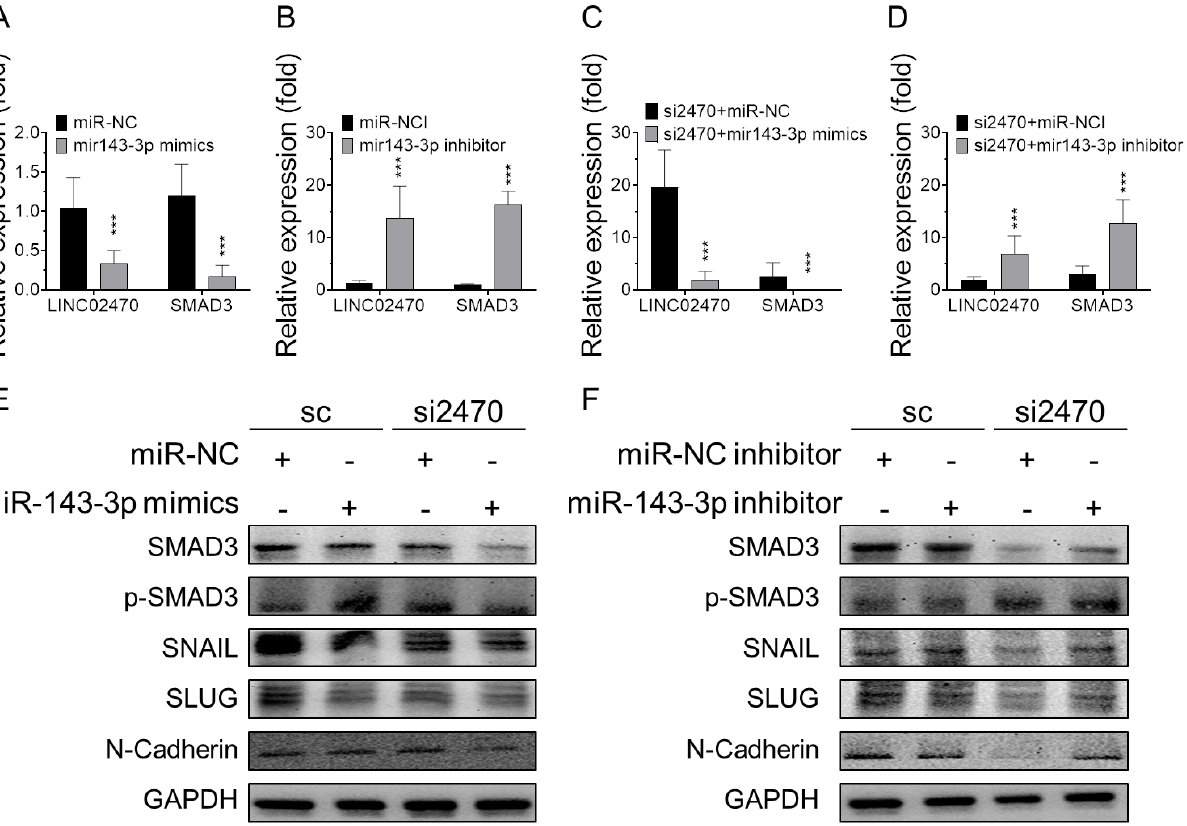
Figure 5. ( A ) LINC02470 and SMAD3 RNA expression levels determined by RT-qPCR were compared in T24 cells transfected with ( A ) miR-143-3p mimic compared to miR-NC control, ( B ) miR-143-3p inhibitor compared to miR-NC inhibitor (NCI) control, ( C ) LINC02470 siRNA combined with miR-143-3p mimic compared to miR-NC control, or ( D ) LINC02470 siRNA combined with miR-143-3p inhibitor compared to NCI control (*** p < 0.001, Student’s t -test). ( E , F ) Protein expression levels of SMAD3 and its downstream EMT markers were compared via Western blotting among the same treated groups.